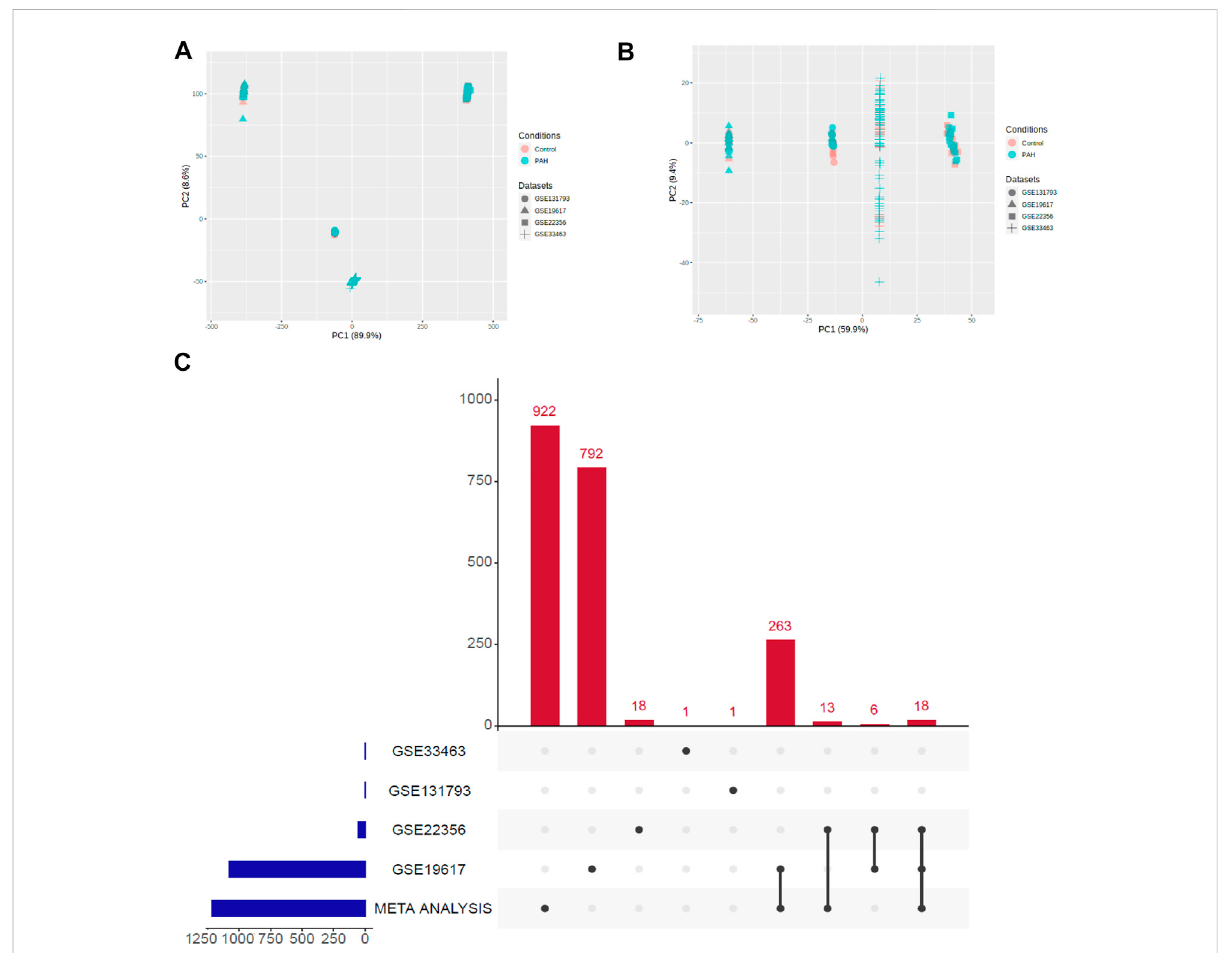
FIGURE 1 Illustration of PCA and upset plot. (A) Before batch effect removal of four different datasets using the ComBat method. (B) After batch effect removal of four different datasets using the ComBat method. (C) An upset plot of gene sets from meta-analysis versus each of the